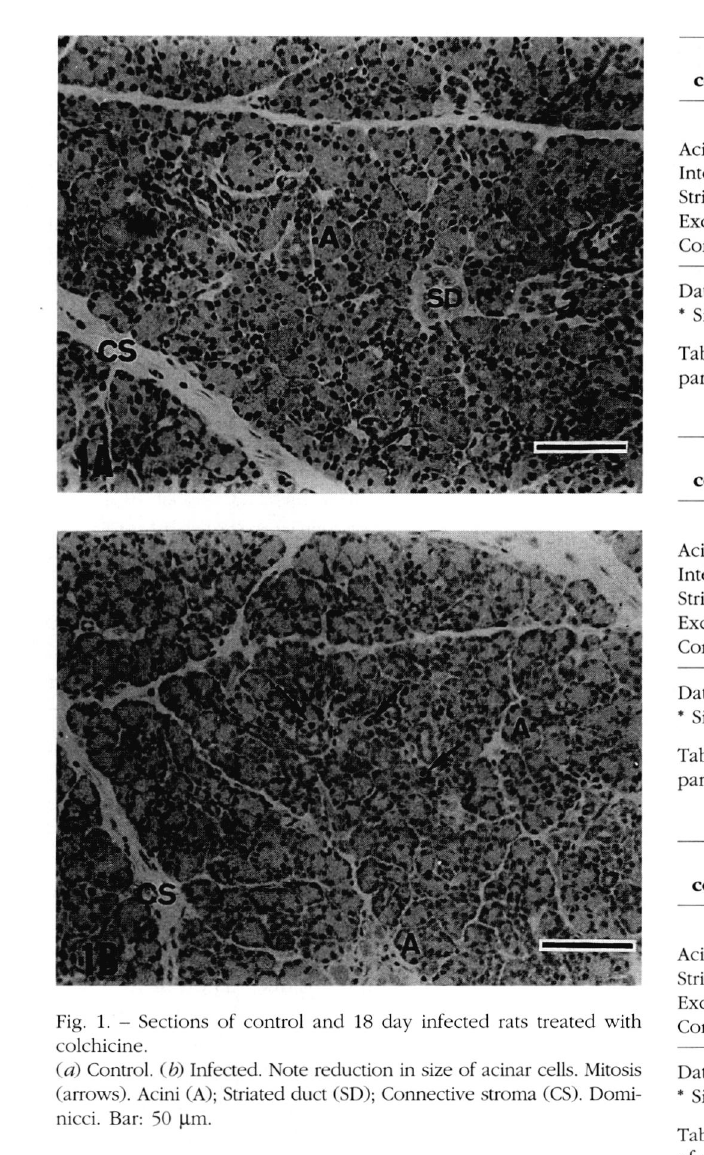
Table IV. — Mean of mitoses number observed in rat parotid gland of control and 18 days infection.